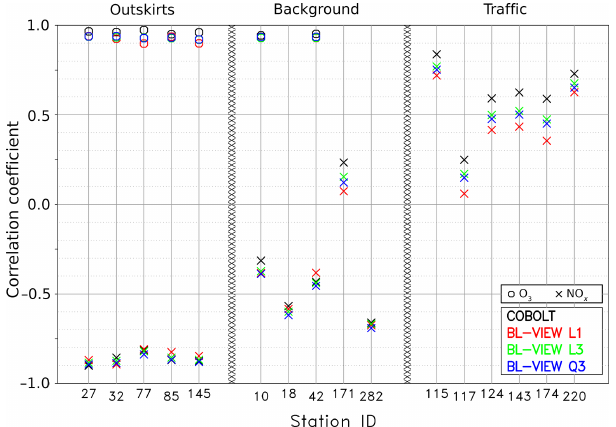
Figure 13. Same as Fig. 12 but the correlation coefficient is based on 1h